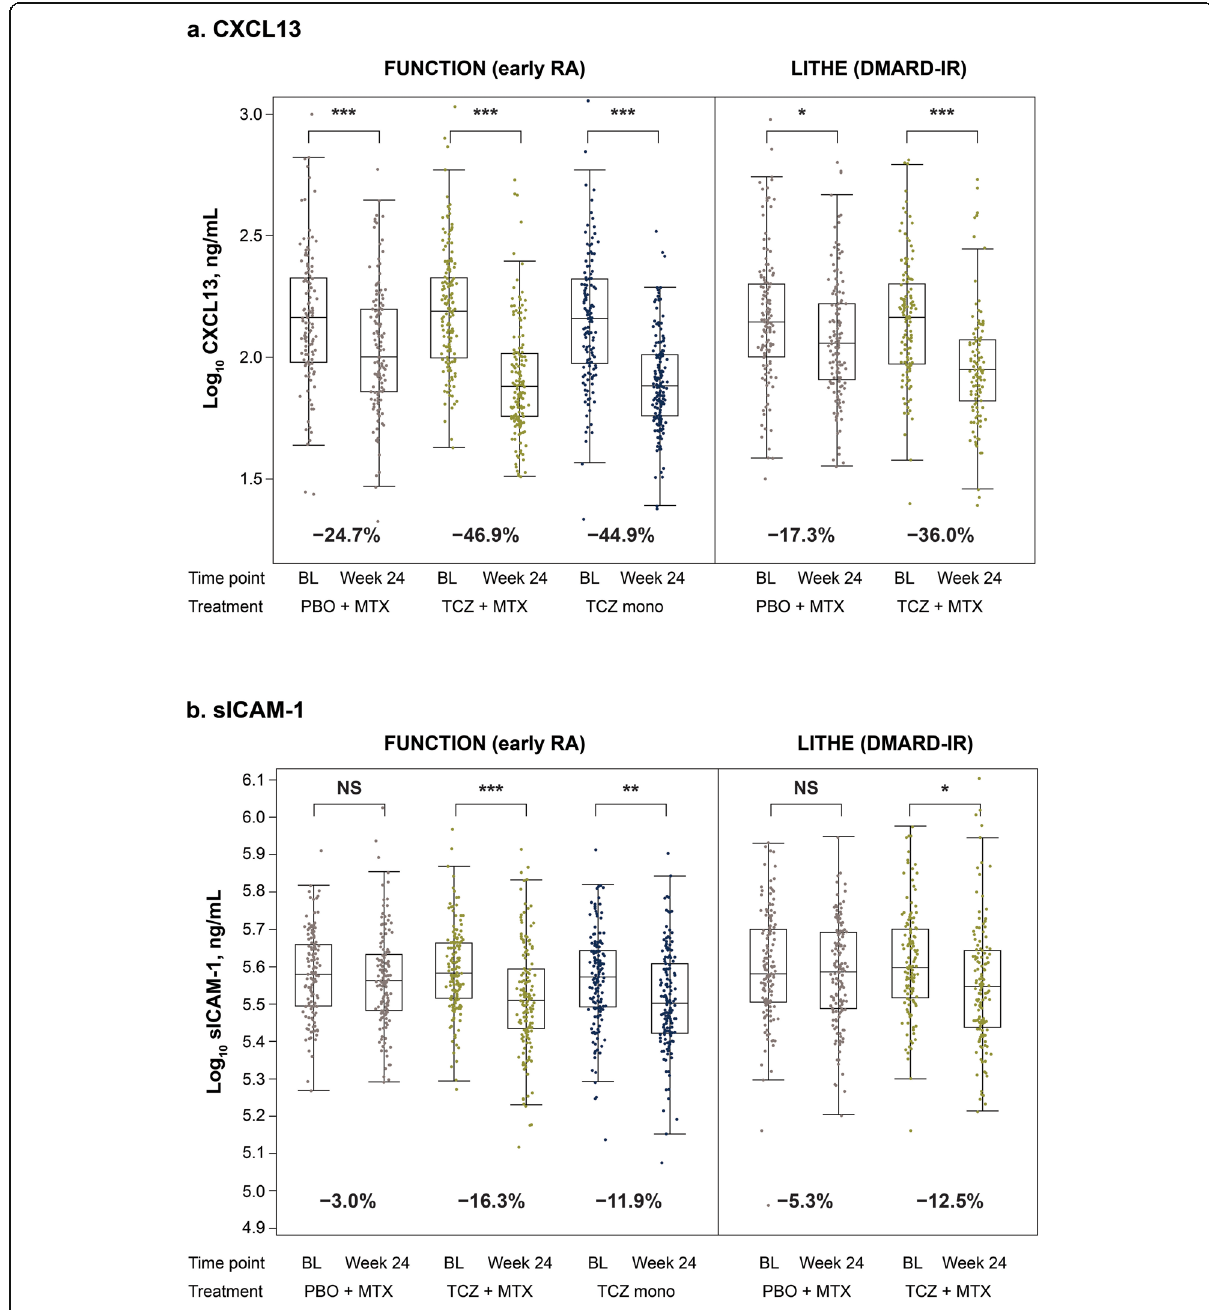
Fig. 3 Change in CXCL13 and sICAM-1 From Baseline to Week 24 by Study and Treatment Arm. a CXCL13. b sICAM-1. BL, baseline; CXCL13, C-X-C motif chemokine ligand 13; DAS28-ESR, Disease Activity Score in 28 joints calculated with erythrocyte sedimentation rate; DMARD-IR, inadequate response to disease-modifying antirheumatic drugs; MTX, methotrexate; NS, not significant; PBO, placebo; RA, rheumatoid arthritis; sICAM-1, soluble intercellular adhesion molecule-1; TCZ, tocilizumab. * P < 0.01. ** P < 0.001. *** P <